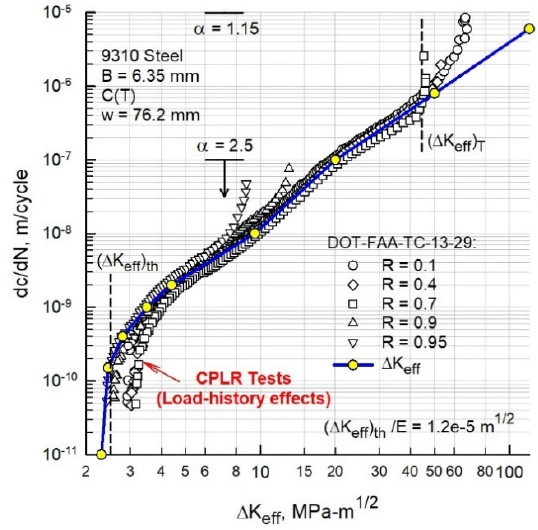
Figure 9. Effective stress-intensity factor range against rate for 9310 steel C(T) specimens. Table 1. Effective stress-intensity factor range against rate, fracture and tensile properties for 9310 steel ( B = 6.35 mm).